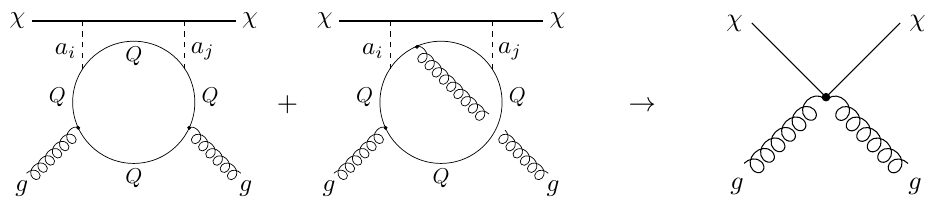
Figure 3 . The two-loop diagrams for the DM-gluon e(cid:11)ective operator, where Q = c; b; t . the loop calculation is mandatory for m t > m a as we will see in later. Second, even if from C box